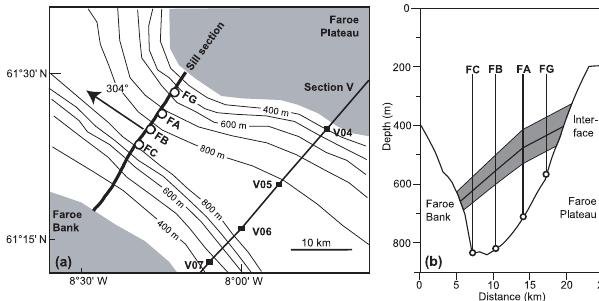
Figure 2. (a) Map showing the sill section with ADCP sites indi- cated by circles and the standard hydrographic section (section V) with standard stations indicated by black squares. The shaded area is shallower than 300m. (b) The sill section with ADCP sites is indicated. The shaded area indicates a typical variation of the inter-